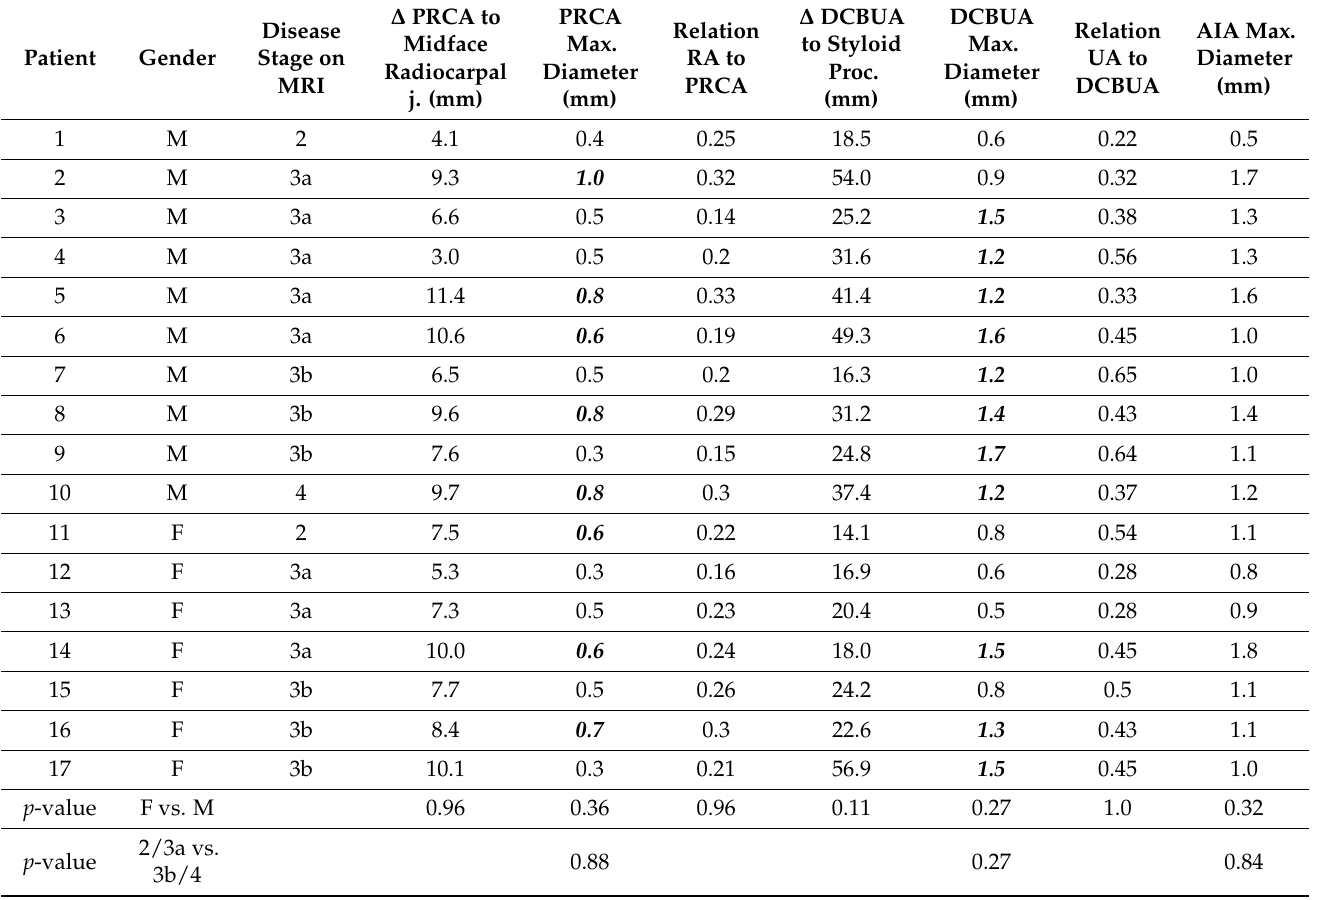
Table 1. Vessel diameters of 17 cases on superselective catheter